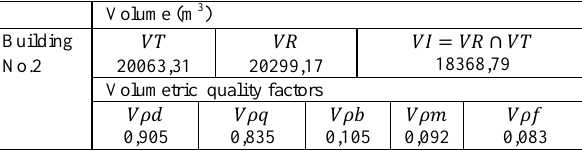
Table 11. Volumes of tested and reference buildings and volumetric quality factors for a building.